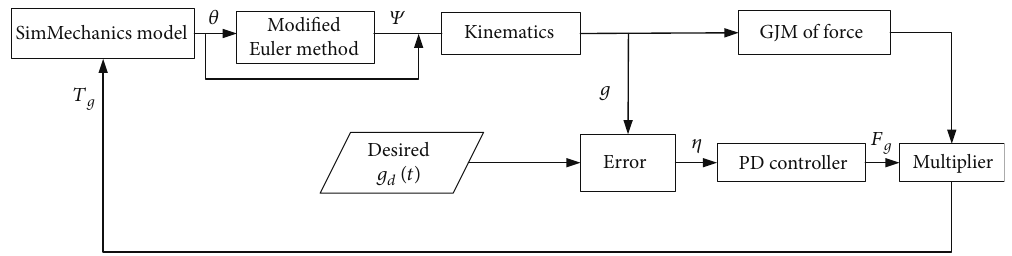
Figure 2: PD control block diagram based on the Jacobi